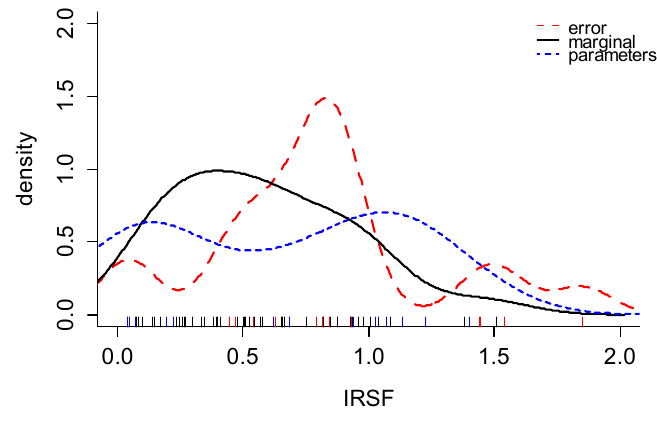
Figure 1. Density estimates of IRSF.